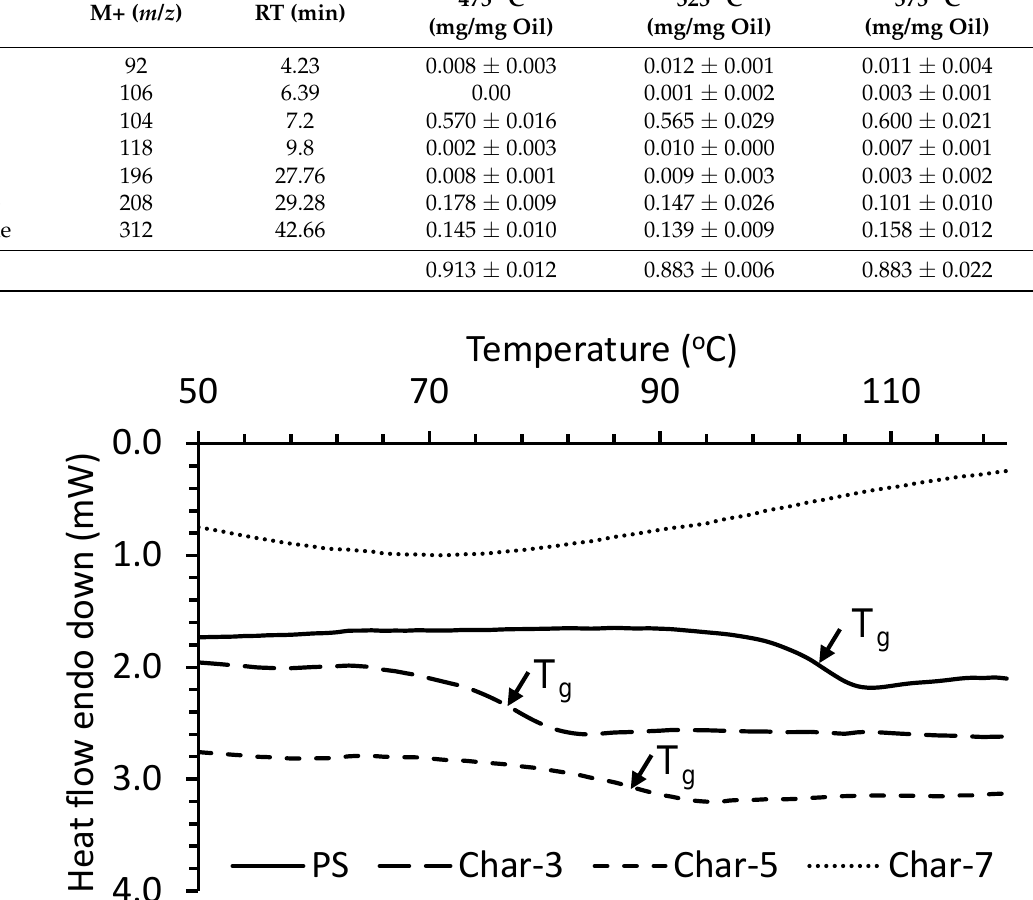
Figure 6. DSC thermograms of PS and char-3, char-5, and char-7.